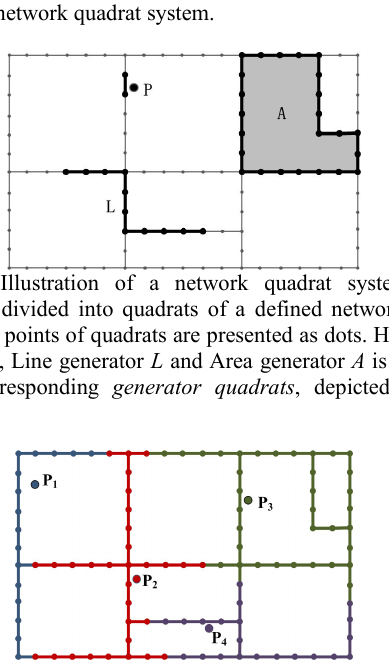
Figure 2. Network Voronoi diagrams within quadrat system (The quadrats showed in different colors belong to the Voronoi subnetworks of the generators with the corresponding